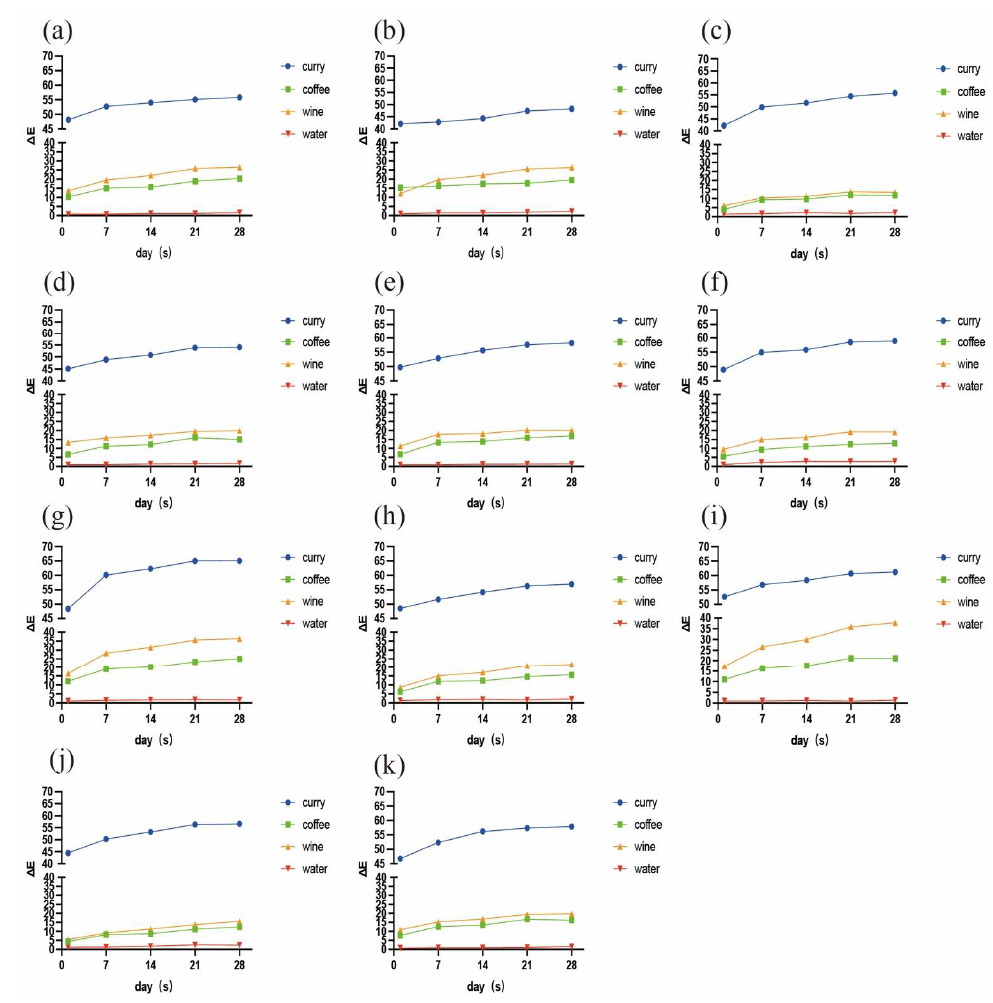
Figure 1. Color changes over time of 11 composite resins immersed in curry, coffee, wine, and distilled water for 1, 7, 14, 21, and 28 days: ( a ) B2; ( b ) F03; ( c ) CXU; ( d ) CS; ( e ) CD; ( f ) DF; ( g ) DXU; ( h ) Z250; ( i ) Z350; ( j ) MP; and ( k ) TNC.